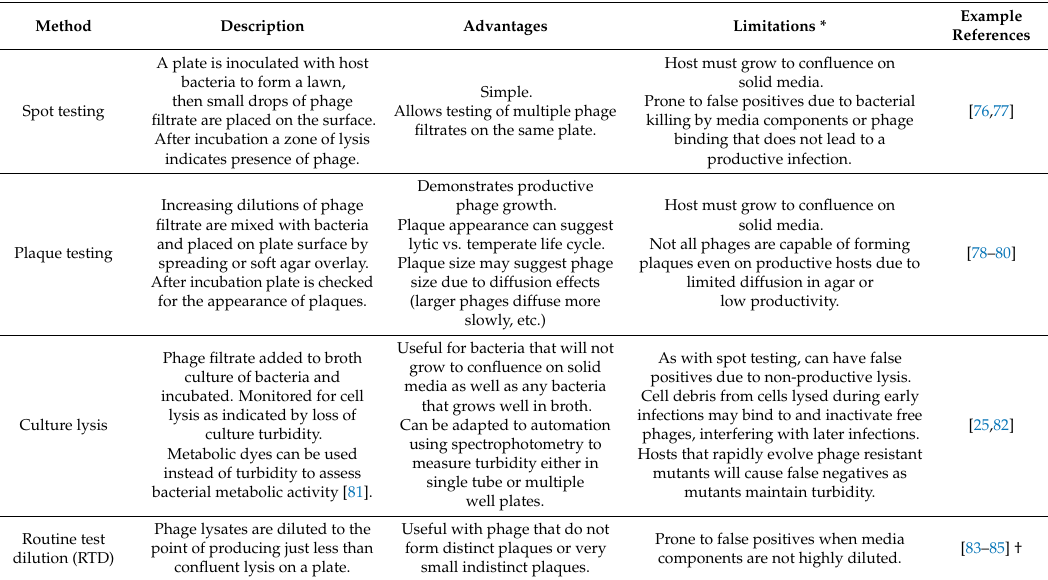
Table 1. Methods for detecting newly isolated